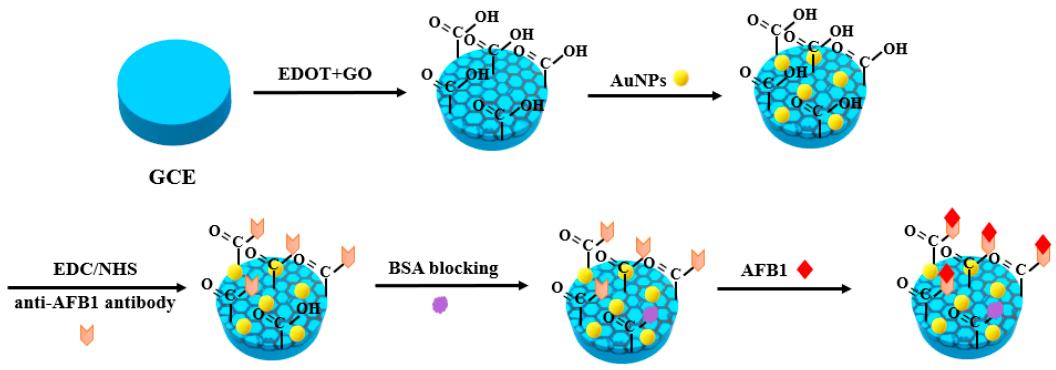
Figure 1. Scheme of BSA/anti-AFB1/AuNPs/PEDOT-GO/GCE-based immunosensor for AFB1 detection.